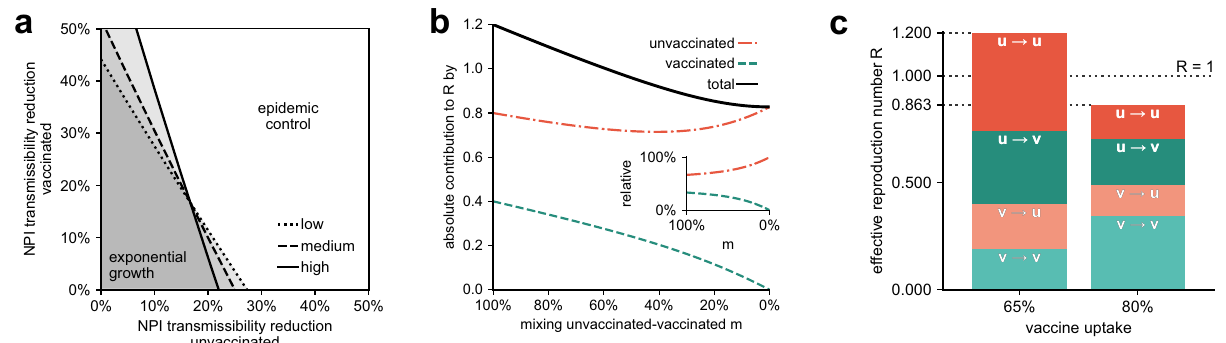
Fig. 2 Ef fi cacy of potential interventions to achieve temporary epidemic control. a Required additional transmissibility reduction for the unvaccinated (horizontal axis) and vaccinated (vertical axis) population to lower R to values below one, based on the assumption that the initial effective reproduction number is equal to R ¼ 1 : 2. b The absolute contributions to R of the unvaccinated (orange) and vaccinated population (green) as well as their sum (black) with decreasing mixing m between both groups, based on the “ medium ef fi cacy ” scenario. The inset shows the respective relative contributions. Note that if heterogeneous mixing was already present during our observational period, the monotonically increasing contribution of the unvaccinated displayed in the inset implies that our results of Fig. 1 are actually lower bounds of the true contribution. c Absolute contributions to R for infections between and across groups of vaccinated and unvaccinated individuals at the vaccine uptake during the observational period (left bar) and a hypothetical vaccine uptake of 80% in the total population, i.e., 90% in the age groups that were, at the time, eligible for vaccination (right bar), based on the “ medium ef fi cacy ” scenario. The latter would have suf fi ced to suppress R suf fi ciently below one, assuming that other factors determining the base transmissibility remained on the same level.